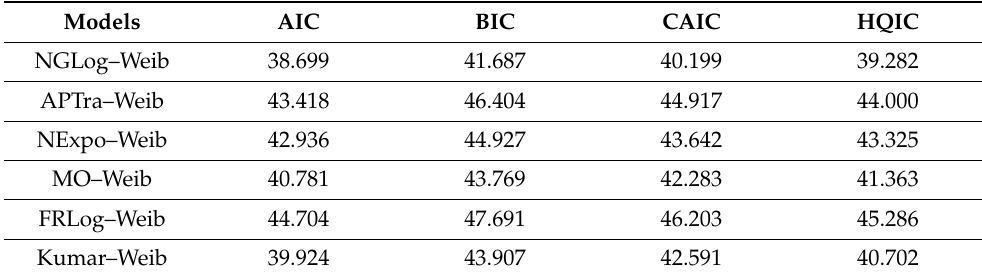
Table 17. The DMs of the competing models for the patients receiving analgesics’ data (dataset Table 16. The GFMs and p -values of the competing models for the patients receiving analgesics’ data (dataset 4).